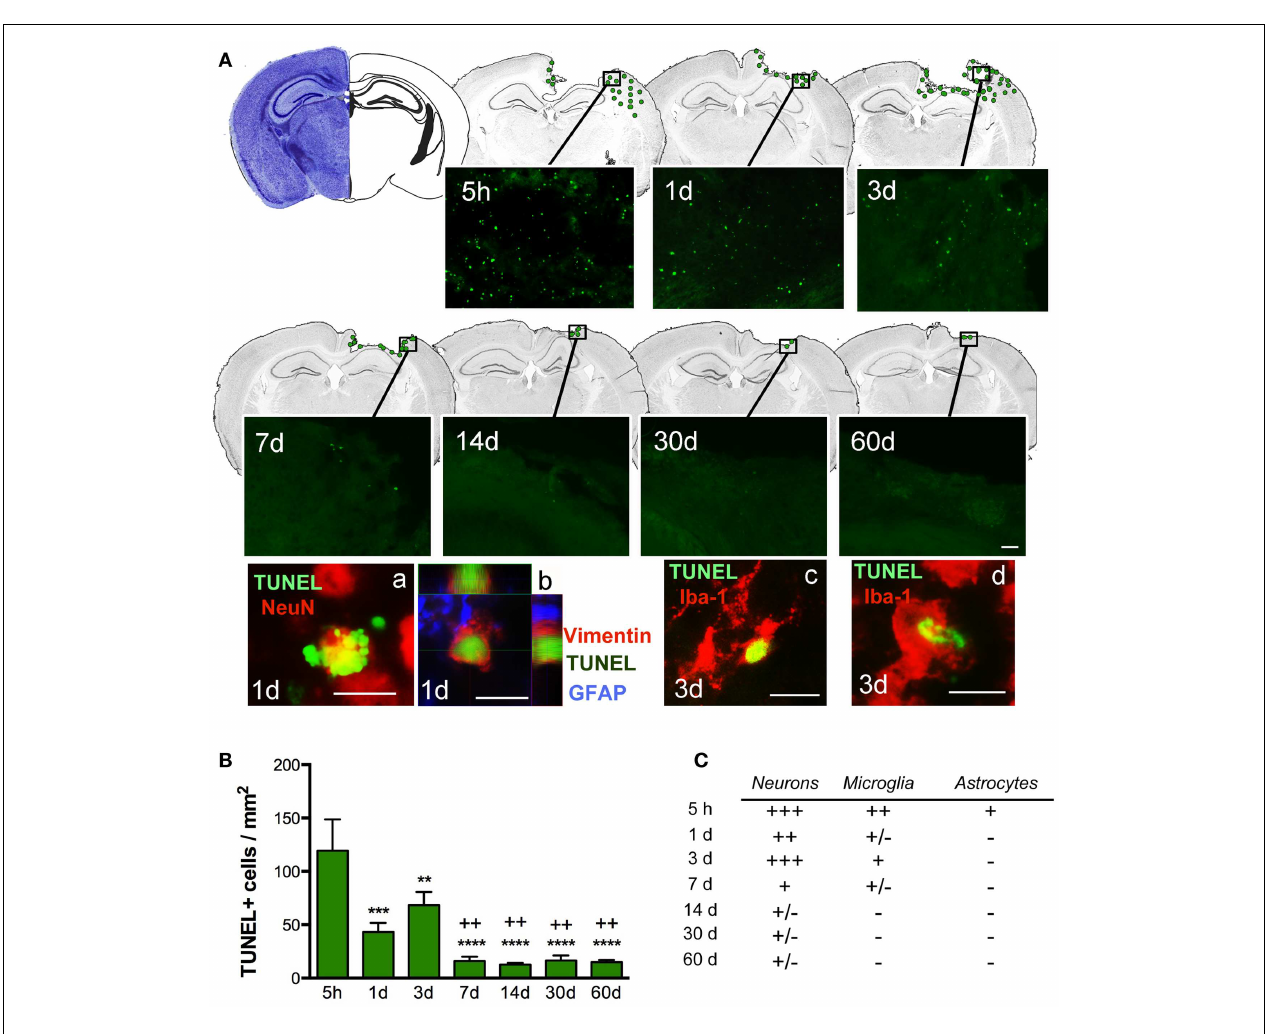
TUNEL-positive cells. Scale bar; 20 µ m (a–d) and 50 µ m (A) . (B) Plot depicts the temporal density ofTUNEL-positive cells in the injured cortex with an early peak at 5h after injury and declining by 7dpi. (C) Table highlighting the identity ofTUNEL-positive cells at different time points. Degree of colocalization ofTUNEL-positive cells with neurons (NeuN), microglia (Iba-1), and astrocytes (GFAP) is graded as; +++ (high), ++ (moderate), + (occasional), ± (in rare cases), and − (no observed) at several time points after CCI injury.Values are expressed as mean ± SEM, n = 3–5 per group, *** p < 0.001, ** p < 0.01, *** p < 0.0001 compared to 5h group ++ p < 0.01 compared to 3dpi